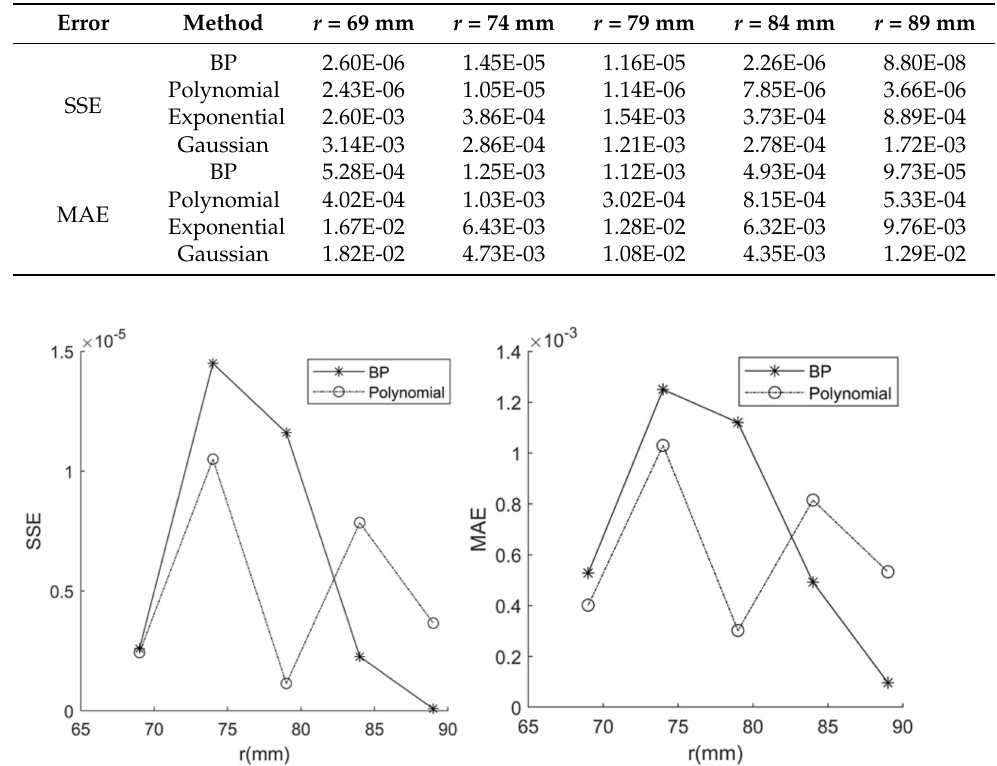
Figure 10. Error comparison between BP neural network and polynomial